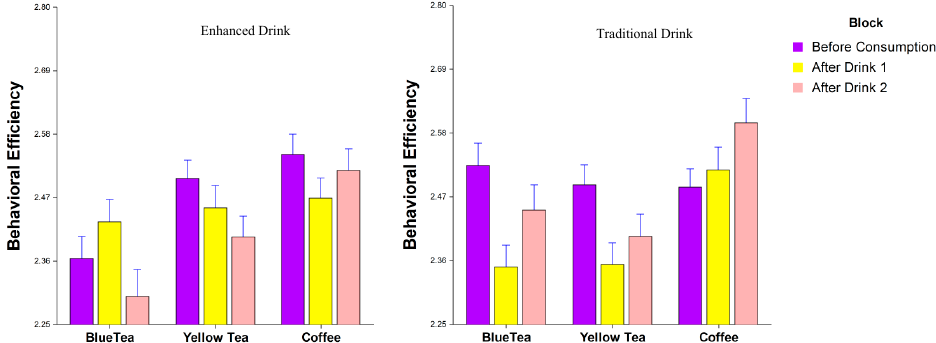
Figure 5. RVP behavioral efficiency. The left graph indicates behavioral efficiency while participants consumed the enhanced drink. The right graph indicates behavioral efficiency while participants consumed the traditional drink. Whiskers represent the SEM.